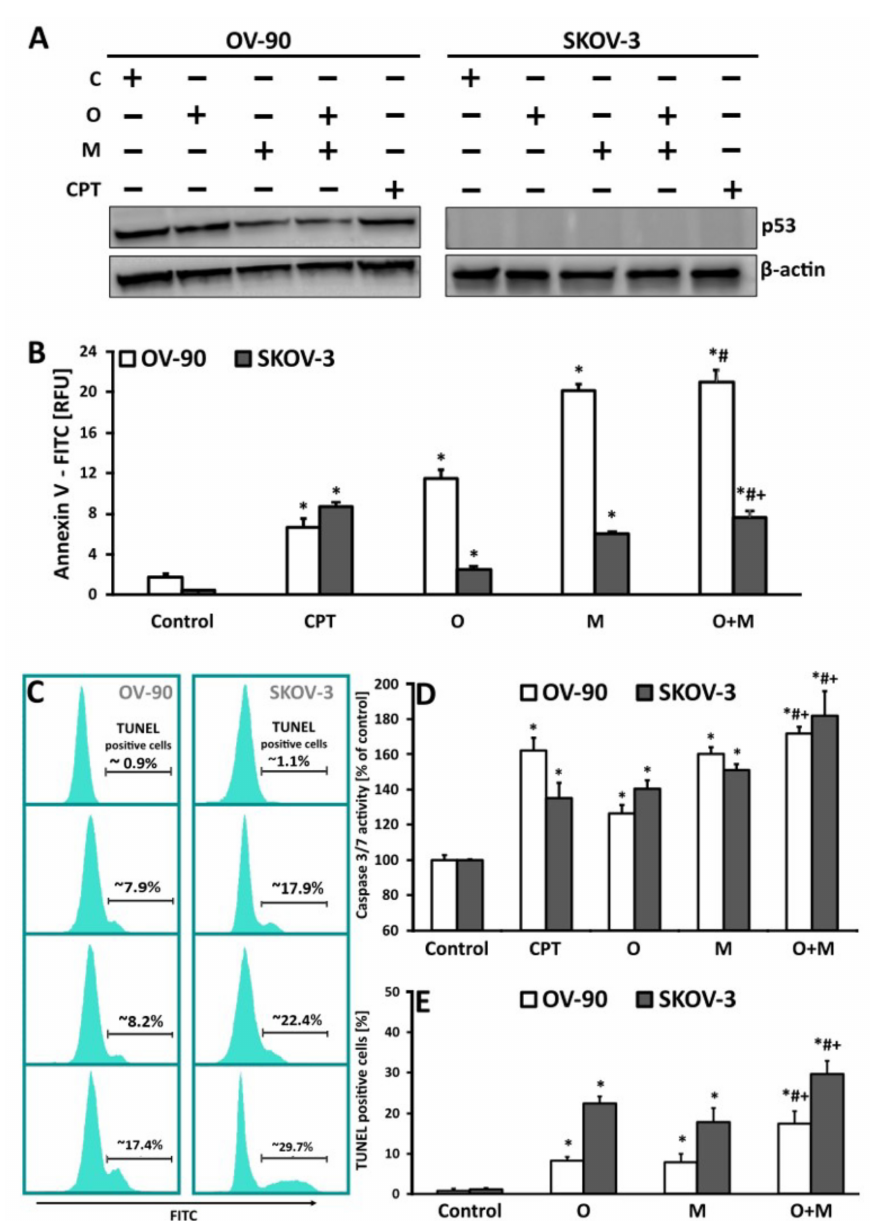
Figure 5. DNA damage and the rate of apoptosis induced by olaparib, metformin, and their combination in OV-90 and SKOV-3 cells. ( A ) The cells were treated with O (20 µ M), M (20 mM), or O (20 µ M) + M (20 mM) with or without CPT (5 µ M) and lysates were collected at 24 h. p53 and β -actin expression was analyzed by western blotting. SKOV-3 has no p53 activity. ( B ) After 24 h of drug treatment, the intensity of Annexin fluorescence was measured in cells with exposed PS. The results are presented as relative fluorescence units [RFU]. ( C ) Representative histograms obtained for samples treated with metformin or olaparib and its combination. The position of the marker representing TUNEL-positive cells (with fragmented DNA) was adjusted according to the negative control. ( D ) Changes in the activity of caspase 3/7 after exposure of SKOV-3 and OV-90 cell lines to metformin or olaparib and their combination for 24 h. The results are presented as a percentage activity of caspase 3/7, where the fluorescence value of the un-treated control was taken as 100%. ( E ) The effect of metformin, olaparib, and their combination on the induction of DNA damage in the SKOV-3 and OV-90 cancer cell lines, as estimated by the TUNEL assay. All data are from the three biologic assays and are graphed as the mean ± SD. * p < 0.05 for olaparib, metformin, or a combination of both drugs vs. control cells; # p < 0.05 for olaparib vs. combination (O + M); + p < 0.05 for metformin vs. combination (O +